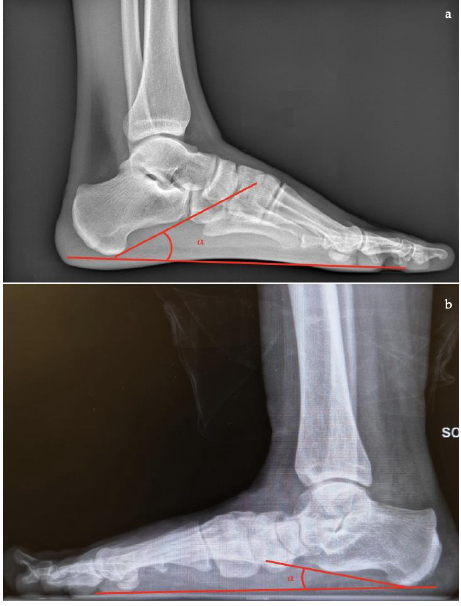
Figure 6. Calcaneal pitch (formed by the line parallel to the ground and the line along the inferior inclination axis of the calcaneus) in the lateral X-ray view. ( a ) Normal foot, 30°; ( b ) pathological flatfoot, 10°.